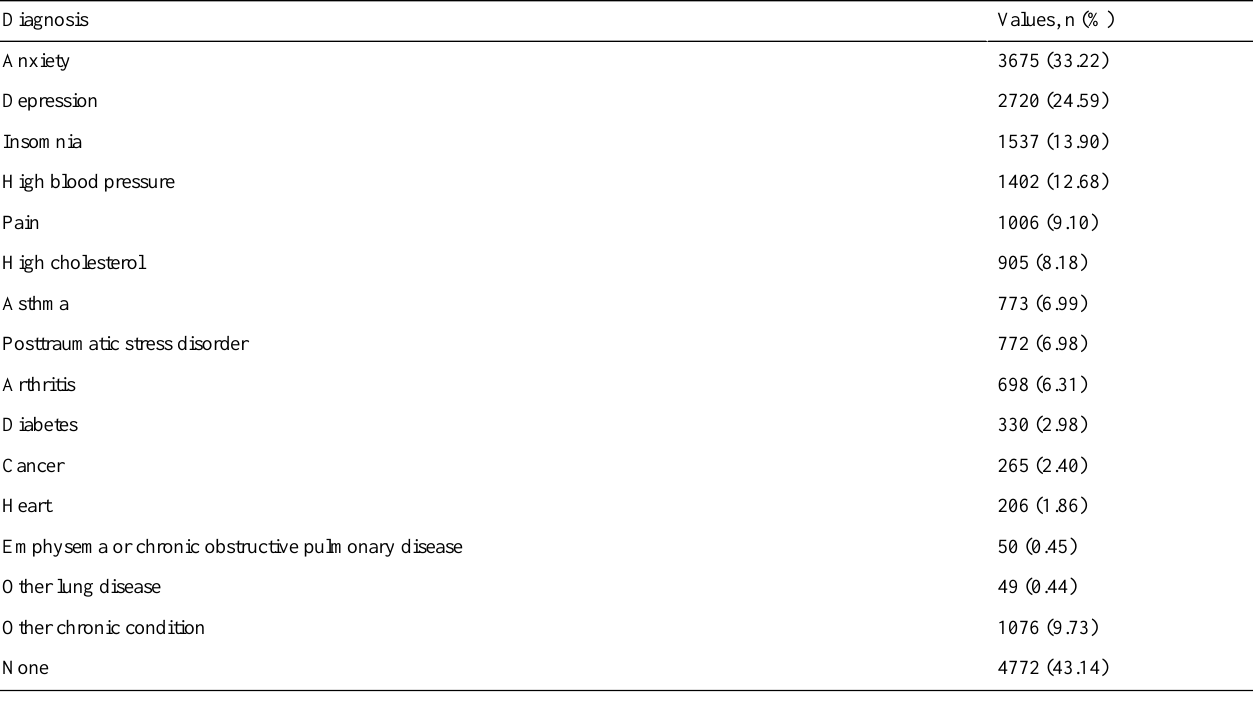
Table 2. Self-reported mental and physical health diagnoses in Calm subscribers (N=11,061).